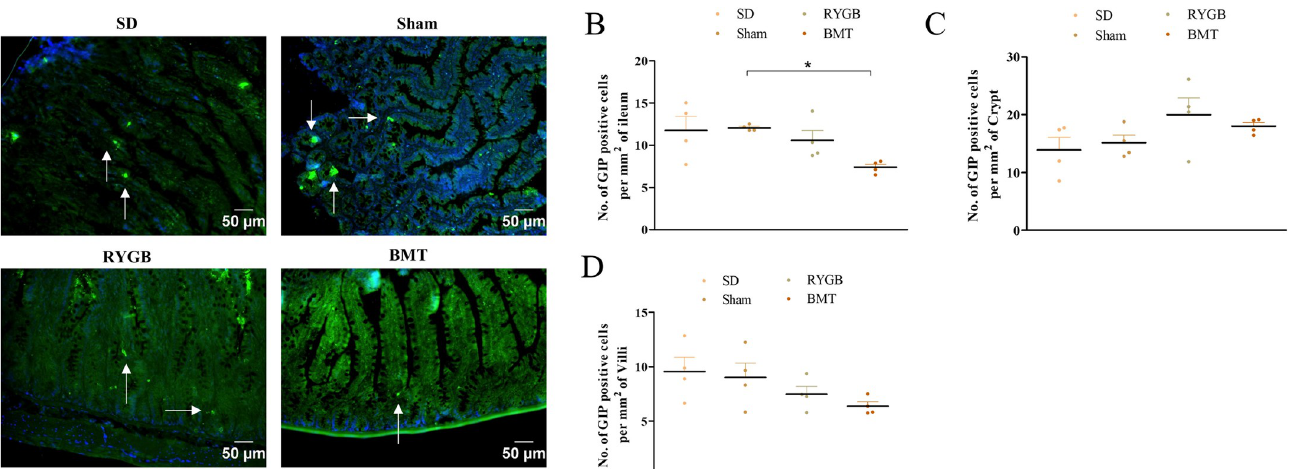
PLOS ONE | https://doi.org/10.1371/journal.pone.0274788 September 22,